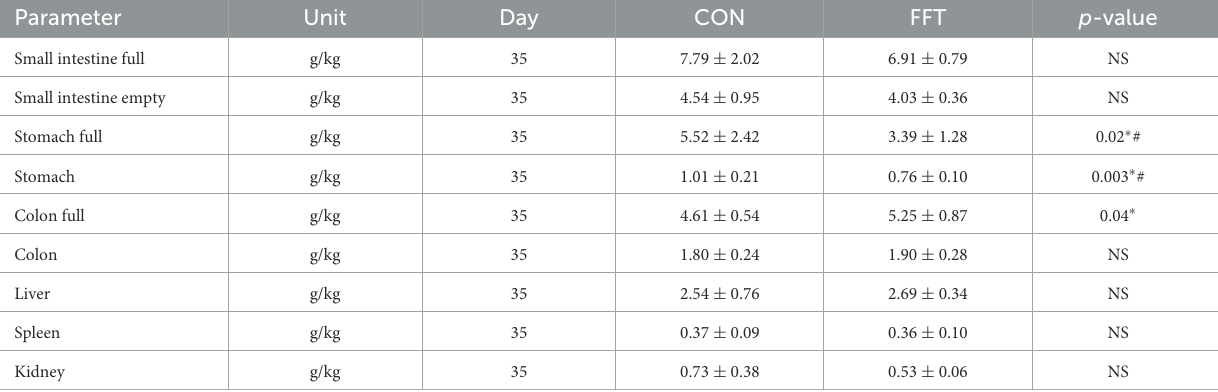
TABLE 5 Relative organ dimensions of piglets euthanized on day 35 ( n = CON: 6; FFT: 8).